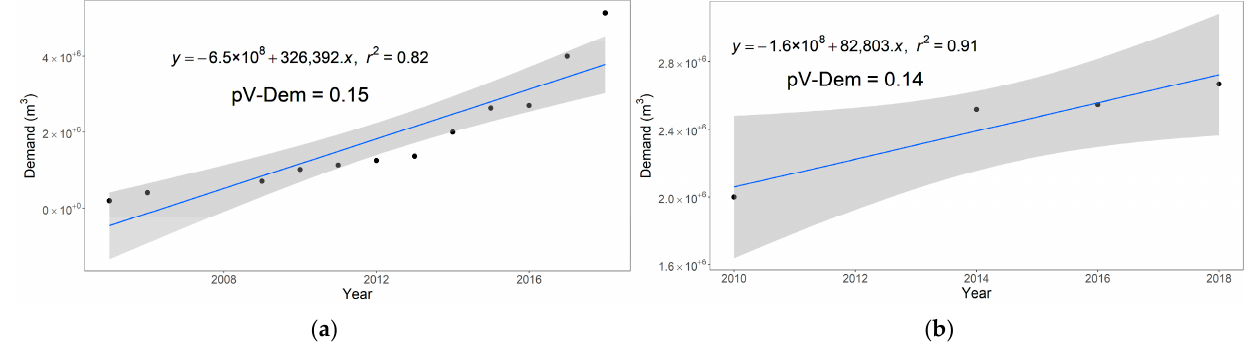
Figure 11. The positive linear trend of industrial demands, ( a ) Sub-basin 1, ( b ) Sub-basin 4.